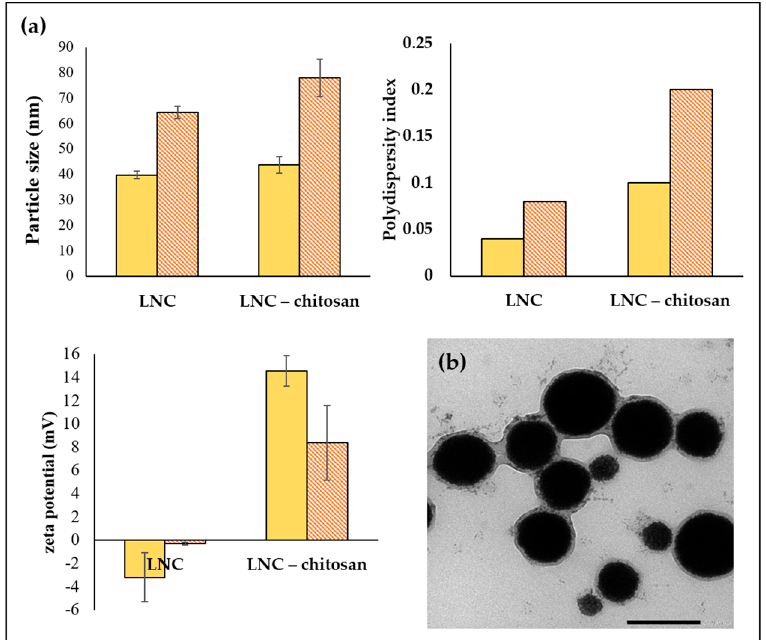
Figure 3. Effect of poloxamer on ( a ) blank LNC and blank LNC-chitosan colloidal properties and ( b ) on morphology of blank LNC. A poloxamer sheath surrounding the LNCs can be seen in Fig- ure 3b at 40,000 magnification.